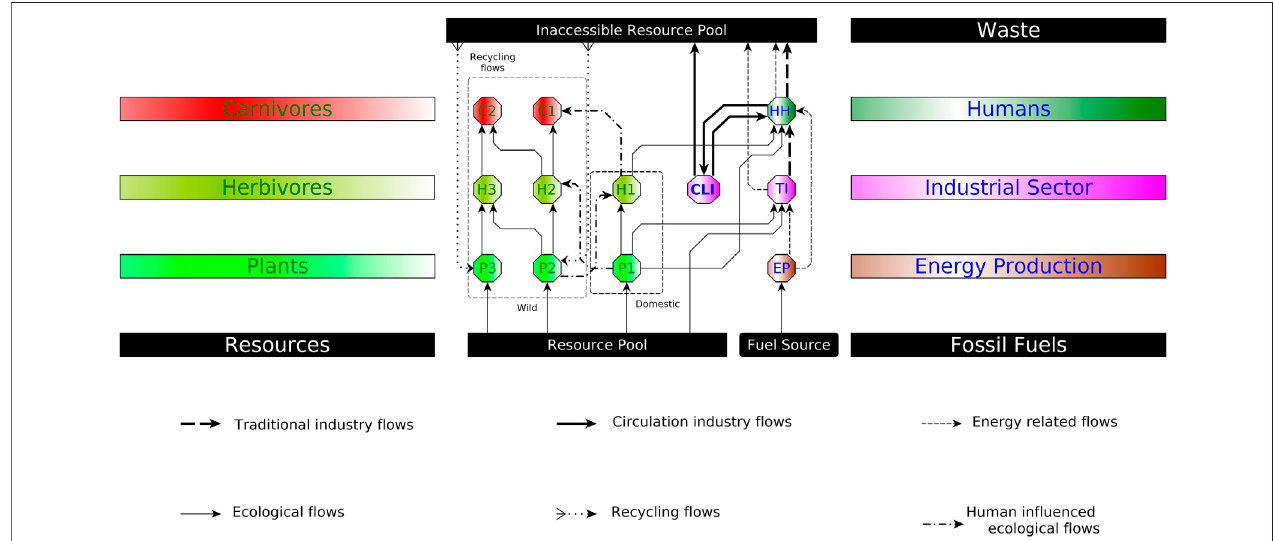
FIGURE 1 | The integrated planetary model: Used consumer goods are processed by the circulation industry and it produces products for consumption. Waste generated in this process is also transferred to the inaccessible resource pool.